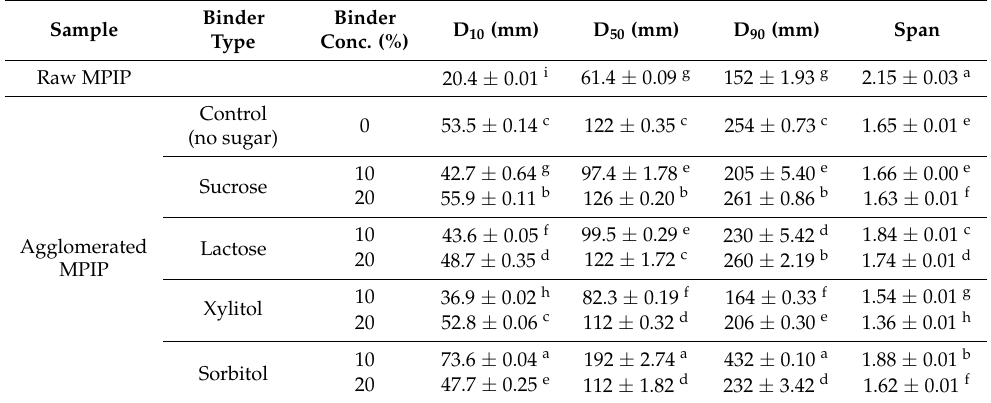
Table 1. Particle diameters of raw and agglomerated MPIPs prepared with various sugar binders at different concentrations.